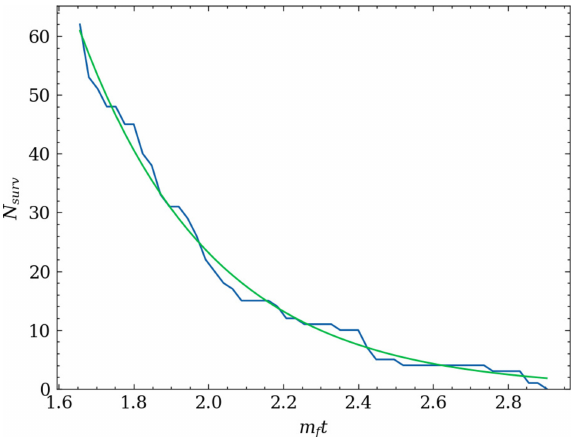
Figure 3 . Example in 1+1 dimensions of the time dependence N surv ( t ) and a fit to the form N 0 e − t Γ . The plot shows the exponential behaviour starting from roughly 60 percent of the total number of configurations, which was N = 100